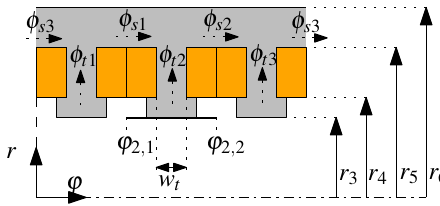
Figure 12. Flux in the stator tooth and yoke.